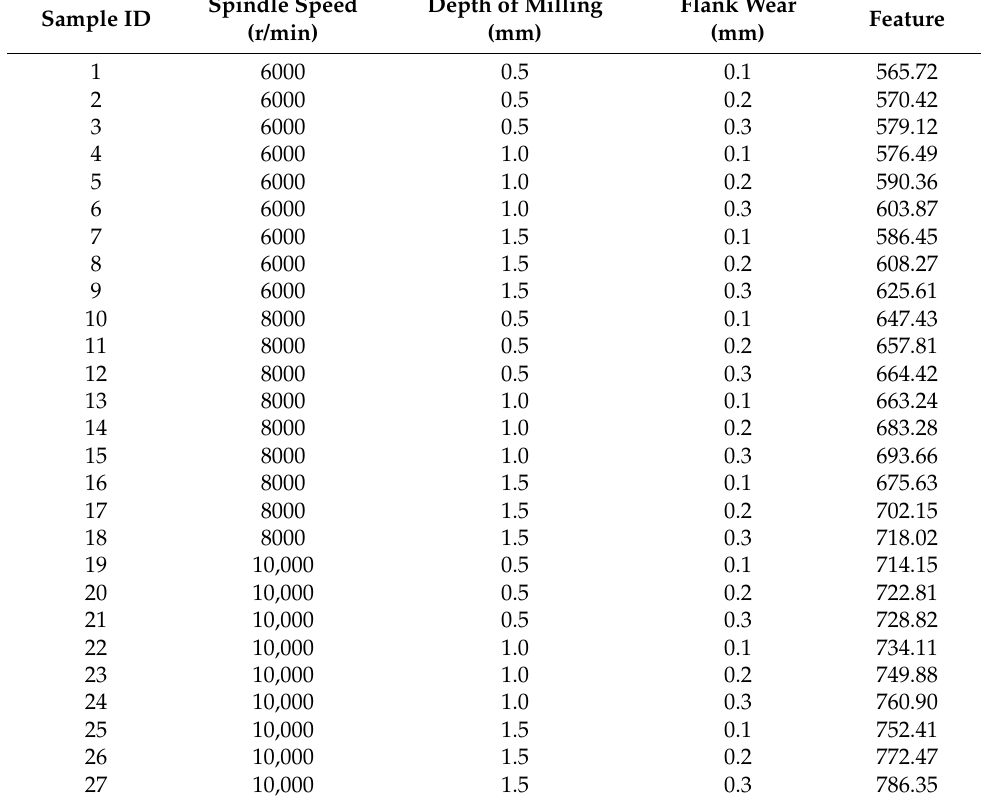
Table 4. Sample of woodworking tool wear